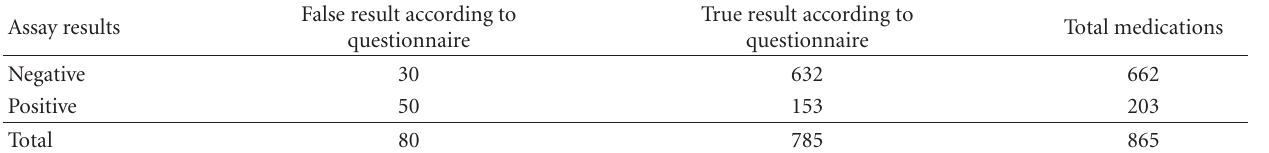
Table 1: Correlation between clinical course and IFN-gamma release results for all medications. Assay